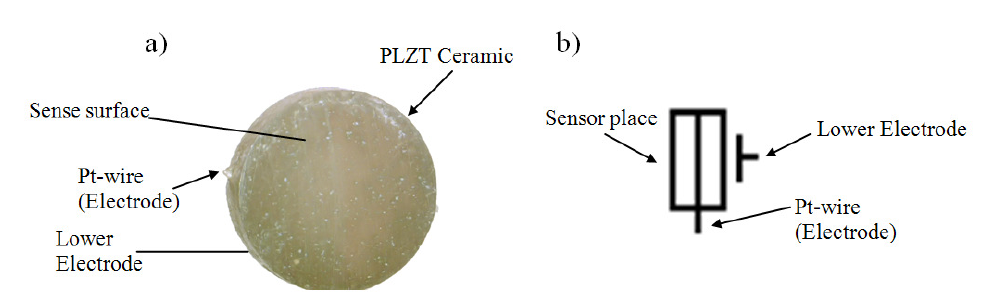
Figure 3. PZPG and its configuration, (a) Schematic PZPG implanted with Pt wire, (b) Graphical Symbol of